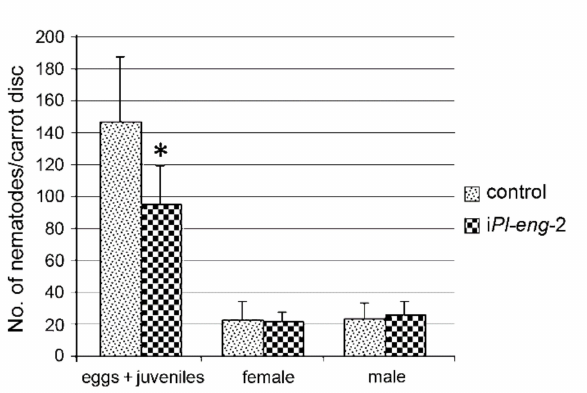
Figure 7. Number of eggs/juveniles and adult females and males recovered from carrot discs 45 days after inoculation with untreated and silenced nematodes. Bars indicate standard errors of the mean data ( n = 3). Significant differences were found between the controls and treated nematodes (* p <